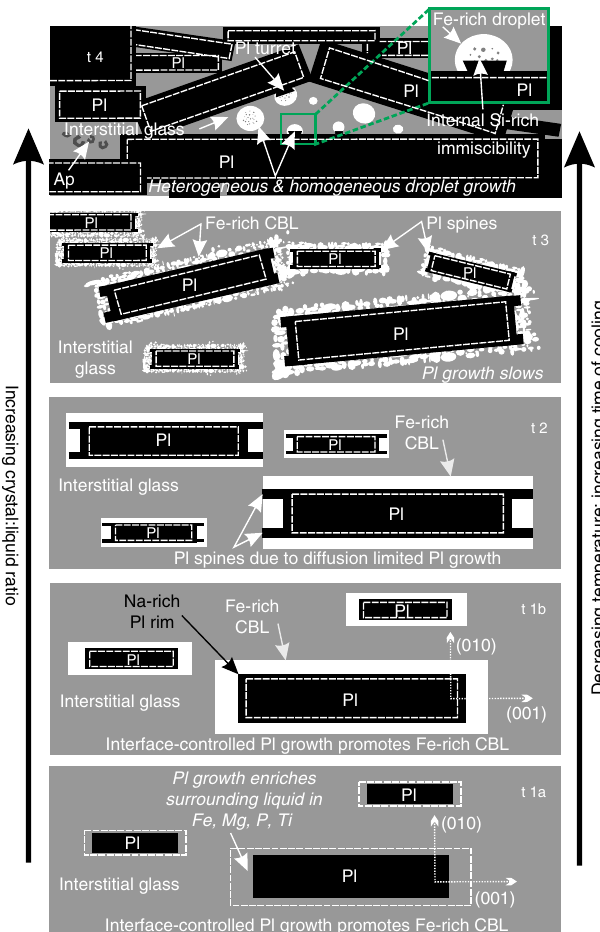
Fig. 4 Schematic evolution of unmixing features with progressive cooling at natural rates. Interface-controlled plagioclase growth promotes the formation of an Fe-rich compositional boundary layer, due to enrichment of the surrounding liquid in metalliferous elements. The Fe-rich CBL evolves temporally, coeval with the increasing crystal:liquid ratio, as a function of time and temperature, from panel t1 to t4, where t4 represents the lowest temperature and longest time of cooling. Overall, the creation of an Fe-rich CBL enriched in components rejected by plagioclase promotes full unmixing in liquids close to the binodal, without the need to nucleate and grow droplets. As plagioclase growth slows, an Fe-rich CBL can no longer be maintained and Fe-rich droplets nucleate both homogeneously and heterogeneously. Note that the processes illustrated in the cartoon are